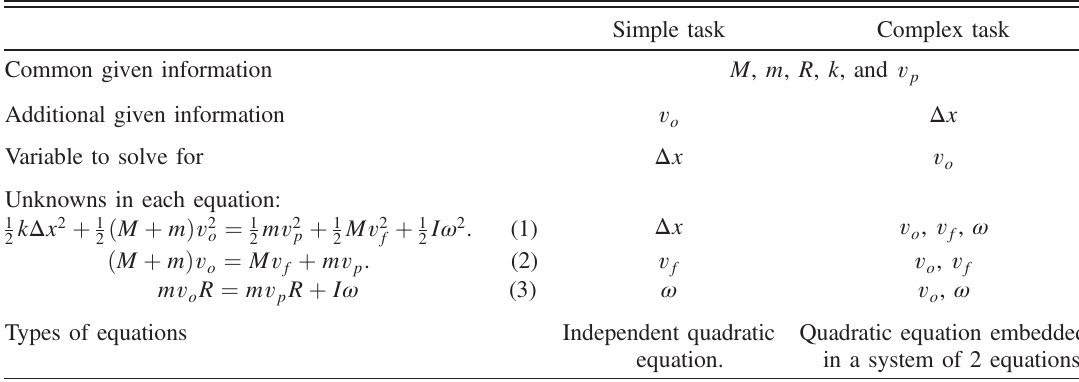
TABLE II. Known and unknown variables, and types of equations across simultaneous synthesis tasks with increasing mathematical complexity ( M , mass of disc; R , radius of disc; v of disc; ω , angular velocity of disc; m , mass of projectile; v initial compression of spring). See Appendix B for the solutions.